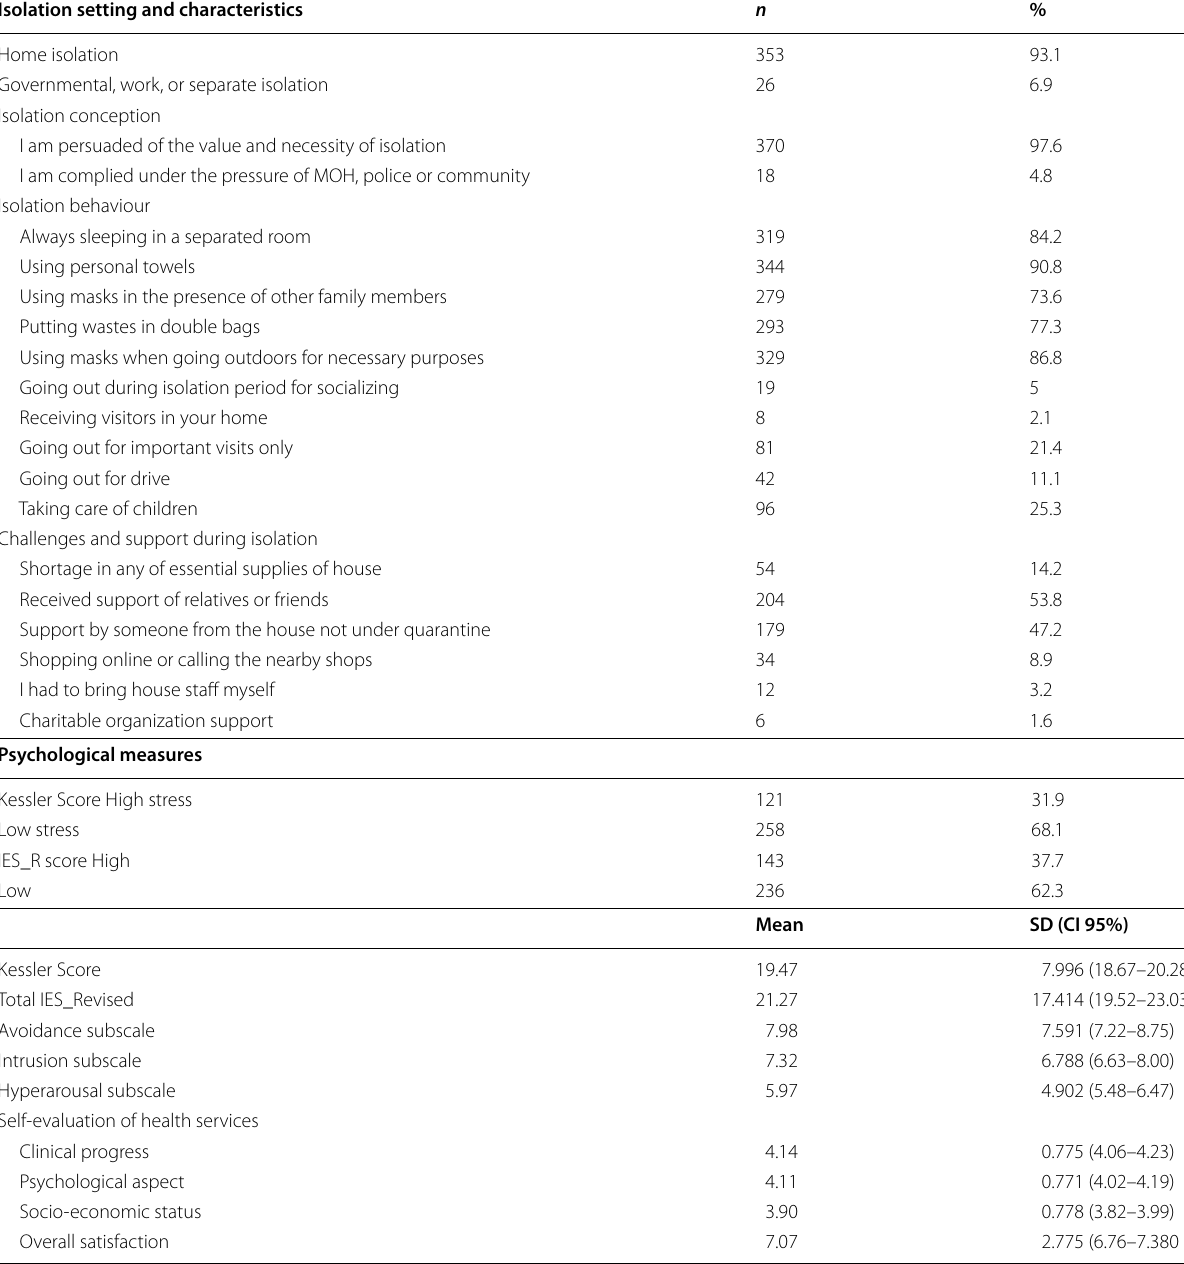
Table 2 Characteristics of the isolation, stress scales, and self-evaluation of participants Isolation setting and characteristics